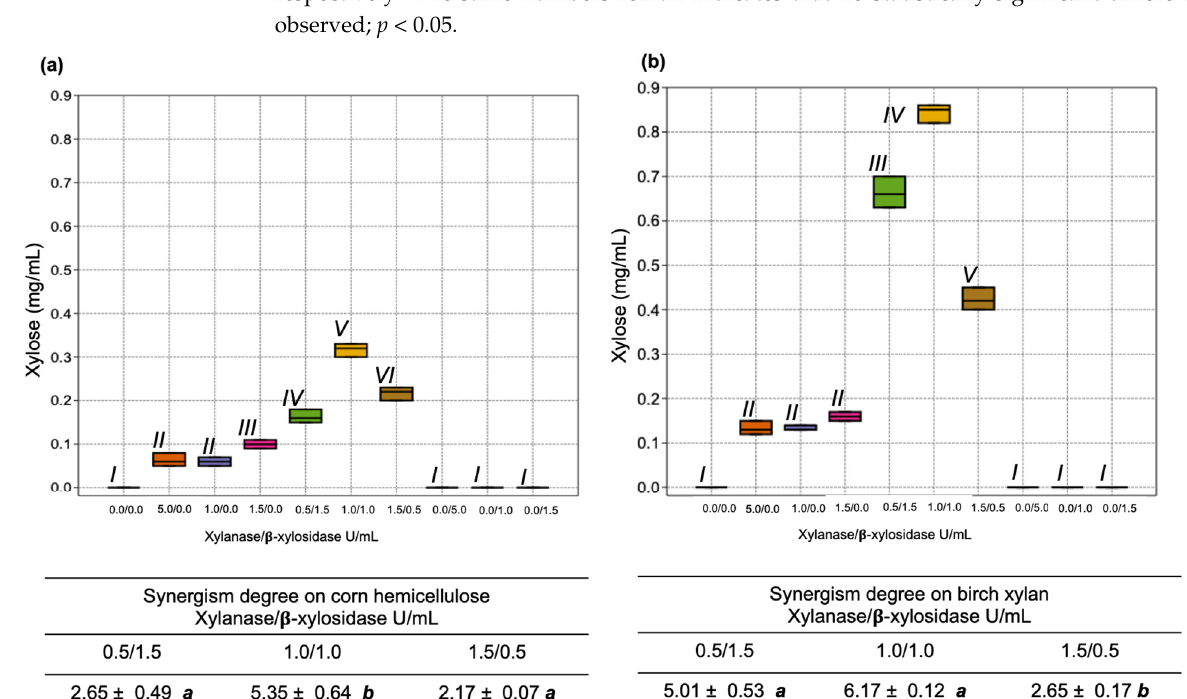
Figure 7. Xylose release and degree of synergism between the actions of xylanase SRXL1 and β -xylosidase SRBX1 from S. reilianum using different enzymatic units in the degradation of corn hemicellulose ( a ) and birch xylan ( b ). The same numbers roman indicates indicate that no statistically significant difference was observed; p < 0.05.